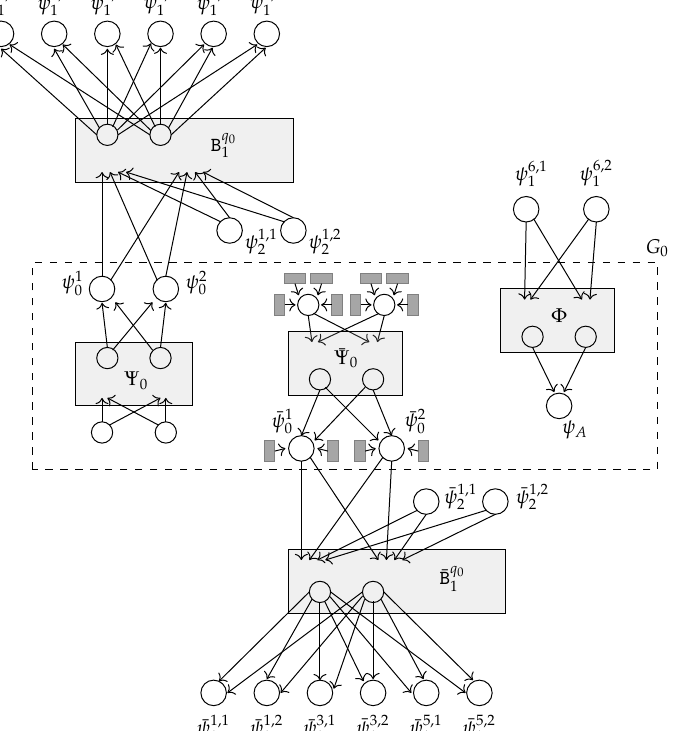
Figure 5. Subgraph G 0 and its connections with G 1 , for the same TM in Figure 4: the quintuples in P are (1): (cid:104) q 0 ,0,1, q 0 , left (cid:105) , (2): (cid:104) q 1 ,0,1, q 0 , right (cid:105) , (3): (cid:104) q 0 ,1,0, q 1 , left (cid:105) , (4): (cid:104) q 1 ,1, b \ , q 0 , right (cid:105) , (5): (cid:104) q 0 , b \ ,1, q 1 , right (cid:105) , (6): (cid:104) q 1 , b \ , b \ , q A , right (cid:105) . Again, stable cliques are depicted as dark grey rect- angles, and the inner nodes in selectors and reverse selectors are depicted as light grey rectangles containing their names with only their input and output nodes explicitly depicted (the input nodes shown outside the